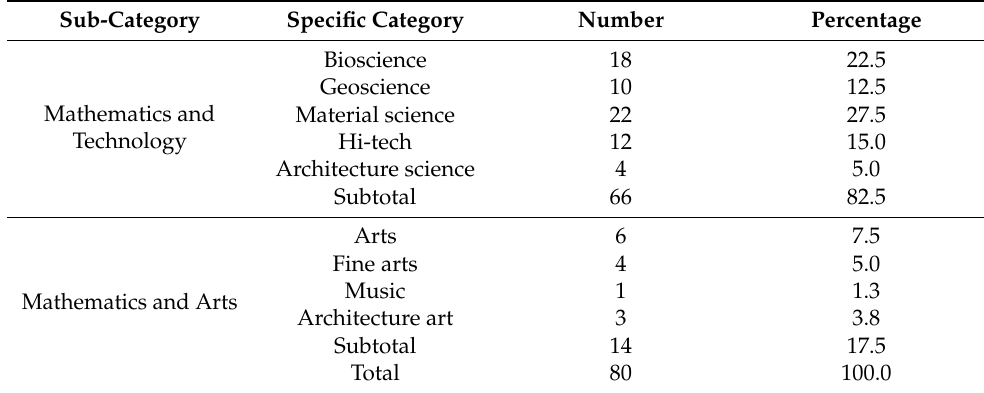
Table 4. The content distribution of the category of Interdisciplinary Connections